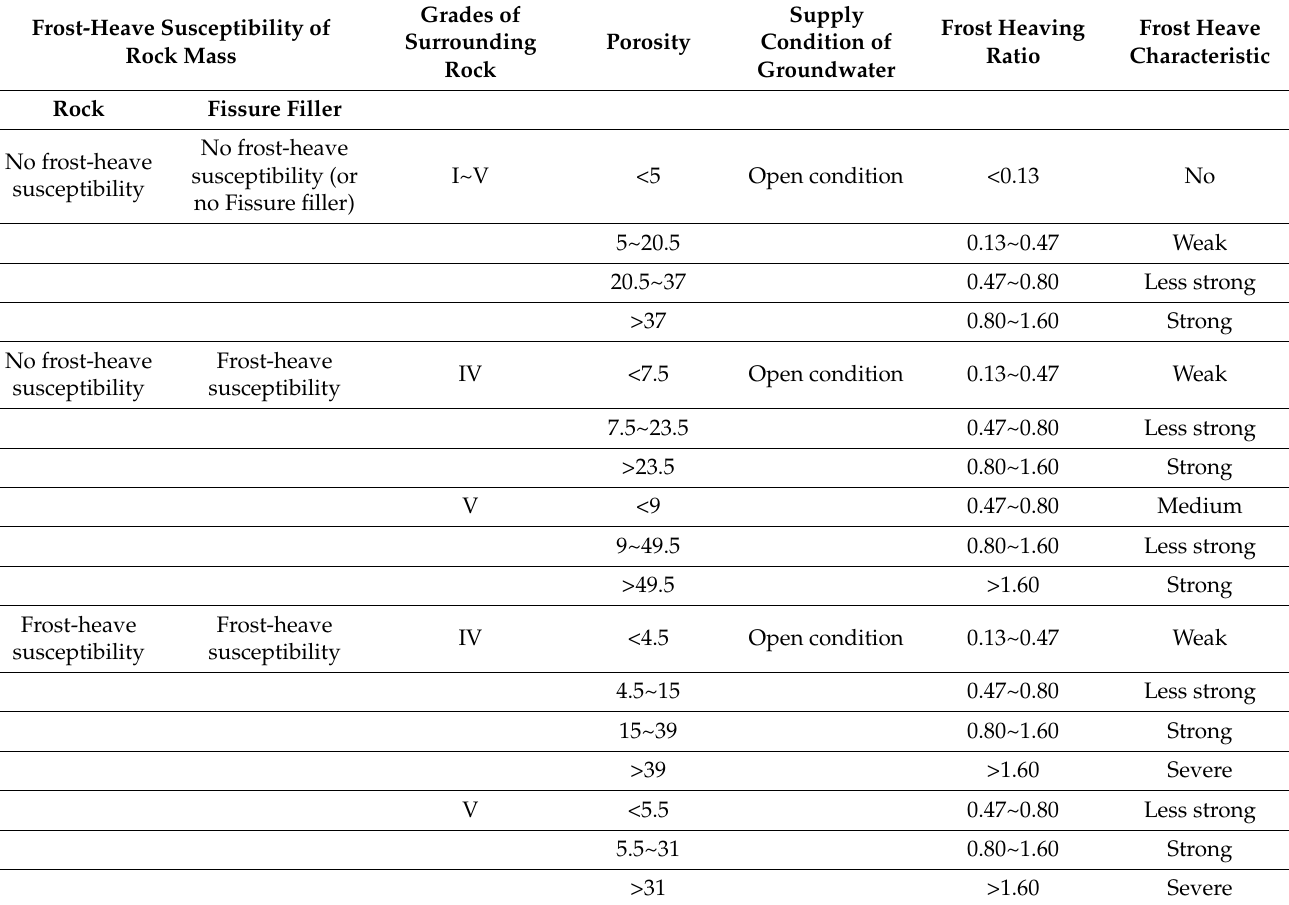
Table 4. Classification of frost-heave susceptibility for rock mass.